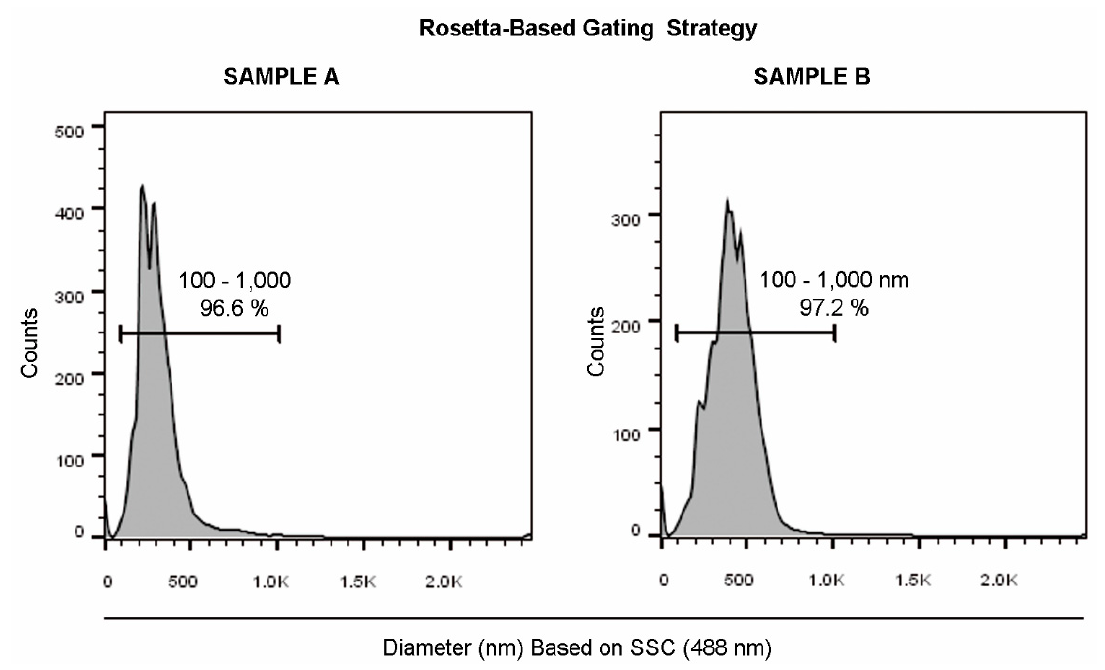
Figure 3. Rosetta bead system analysis of liposomes. The EV dimensional region (100–1000 nm) was defined on a diameter histogram (FCS files transformed by the Rosetta Calibration system). Sample A and B are represented.